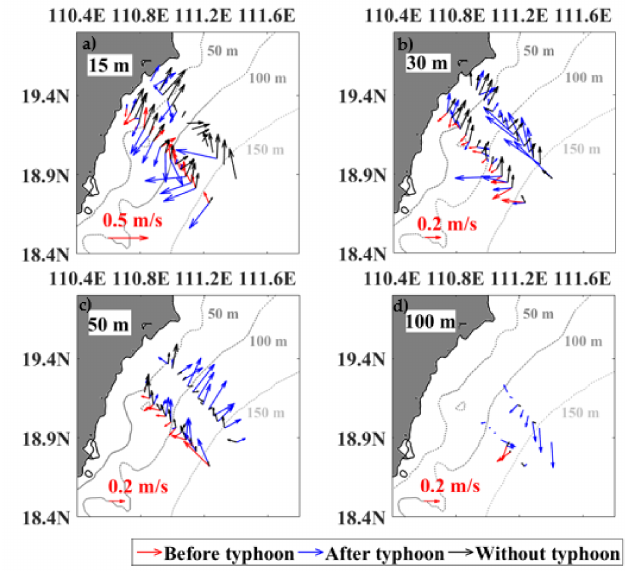
Figure 4. Distributions of current velocities after de-tided processing at a depth layer of 15 m ( a ), 30 m ( b ), 50 m ( c ), and 100 m ( d ). Gray dashed lines represent isobaths of 50, 100, and 150